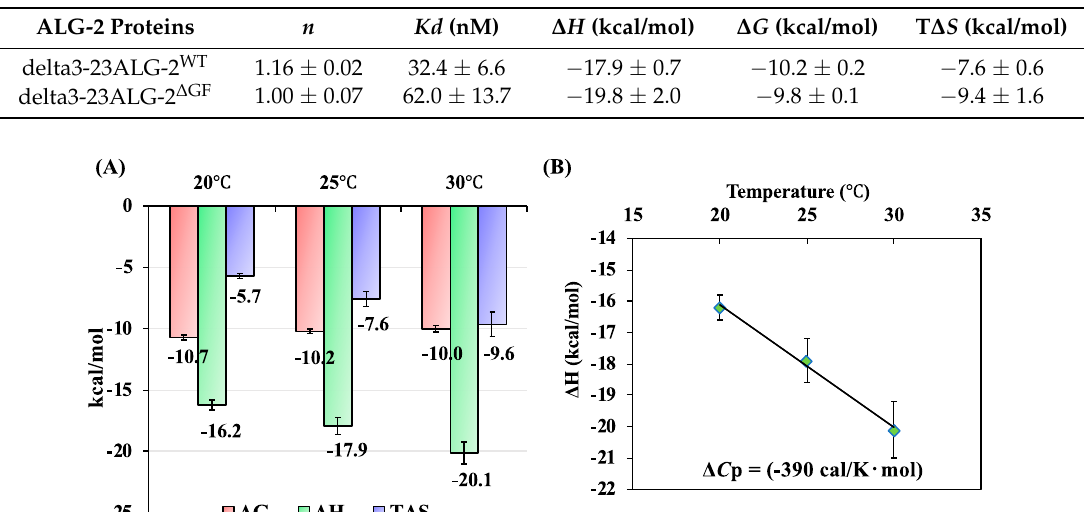
Table 1. Thermodynamic parameters for the interaction between SOUL WT and delta3-23ALG-2 WT or delta3-23ALG-2 ∆ GF at 25 °C.